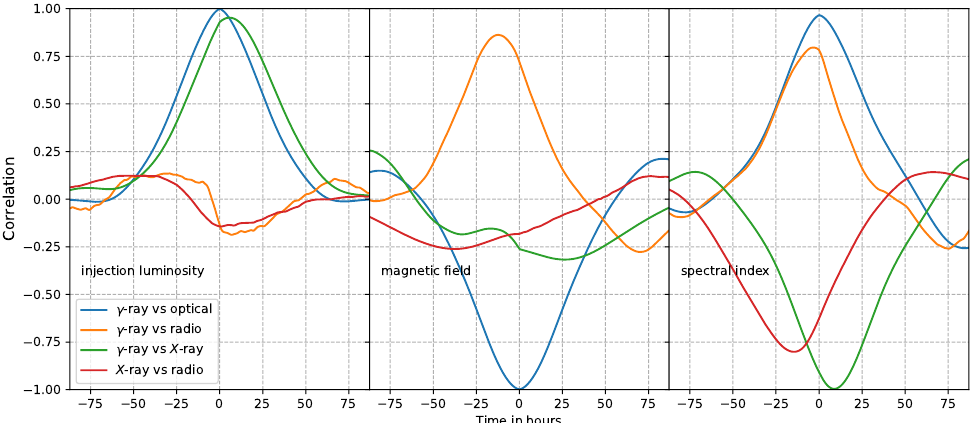
Figure 6. Light curve correlations for variations of different properties.